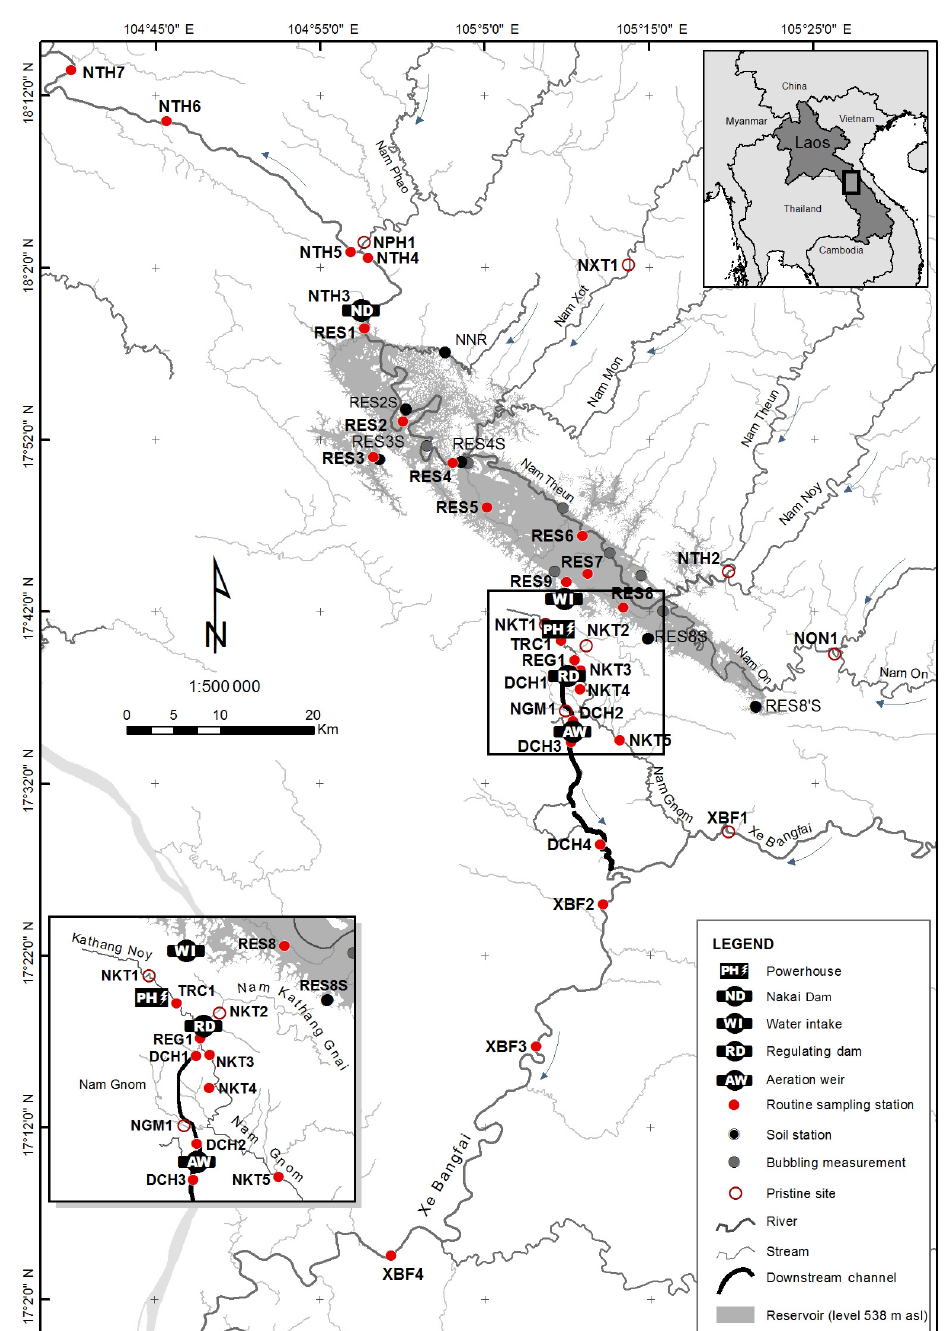
Figure 1. Map of the Nam Theun 2 monitoring network. The station names are defined by numbers and an abbreviated name as follow: RES standing for reservoir, NTH for Nam Theun River, NON for Nam On River, NXT for Nam Xot, NPH1 for Nam Phao River, TRC for tail race channel, REG for regulation pond, DCH for downstream channel, NKT for Nam Kathang River, NGM for Nam Gnom and XBF for Xe Bangfai